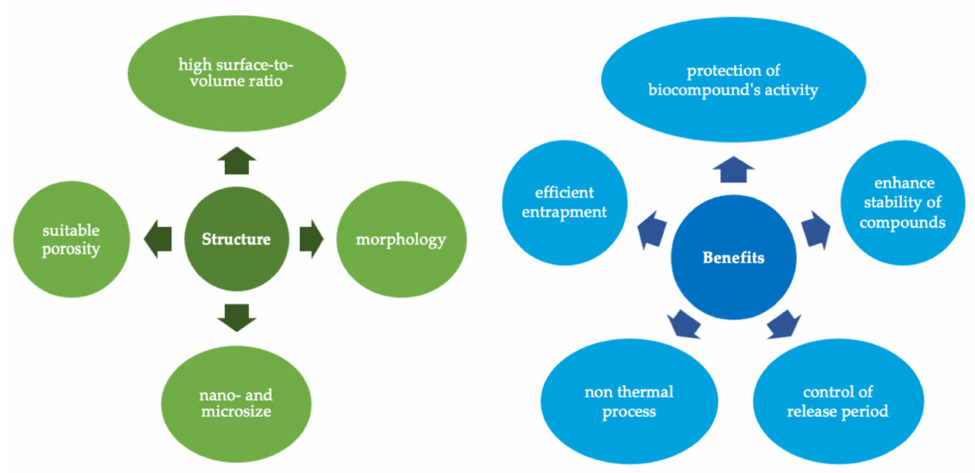
Figure 4. Advantages of electrospun/electrospray structures for food